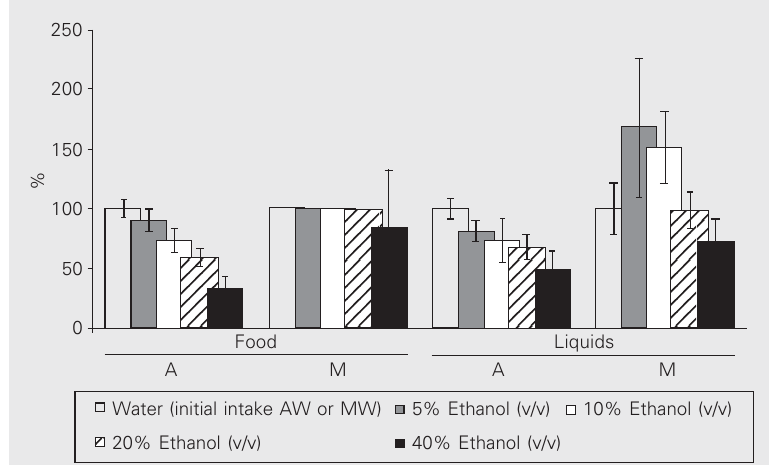
Figure 1. Effect of ethanol concentration in drinking water on food and water intake during the well nourished (A) and malnourished (M) phases. Data are reported as percent intake by the water group (AW and MW) rats. Food (100%) = AW: 17 g and MW: 8 g; liquids (100%) = AW: 26.9 ml and MW: 14.1